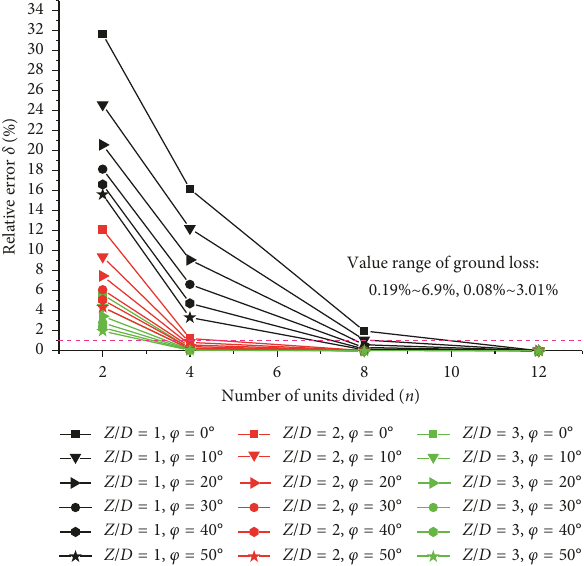
Figure 6: Trend of δ with n . Table 2: Recommended value of n